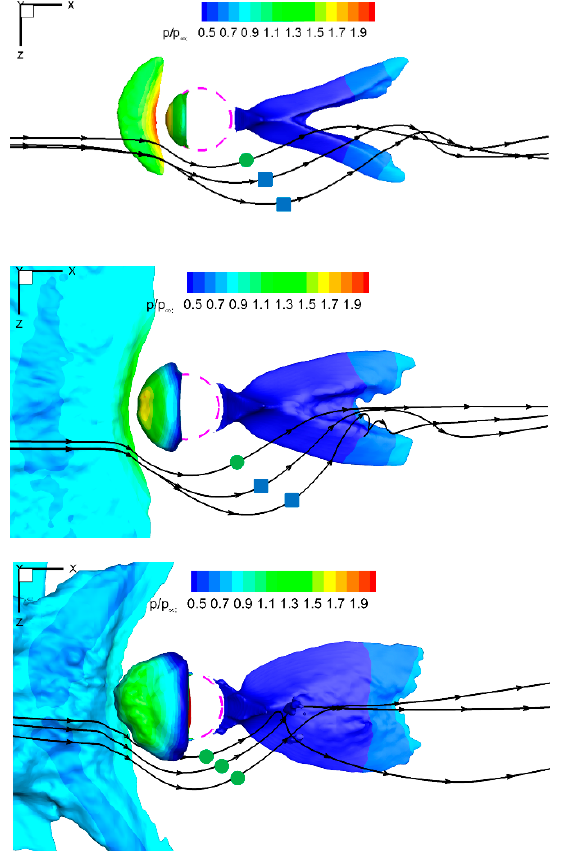
Figure 8. Top view of the isosurface of the flow velocity ( u / u ∞ = 1 × 10 − 5 ) colored by the pressure contour and overlapped by streamlines bypassing the recirculation zone.